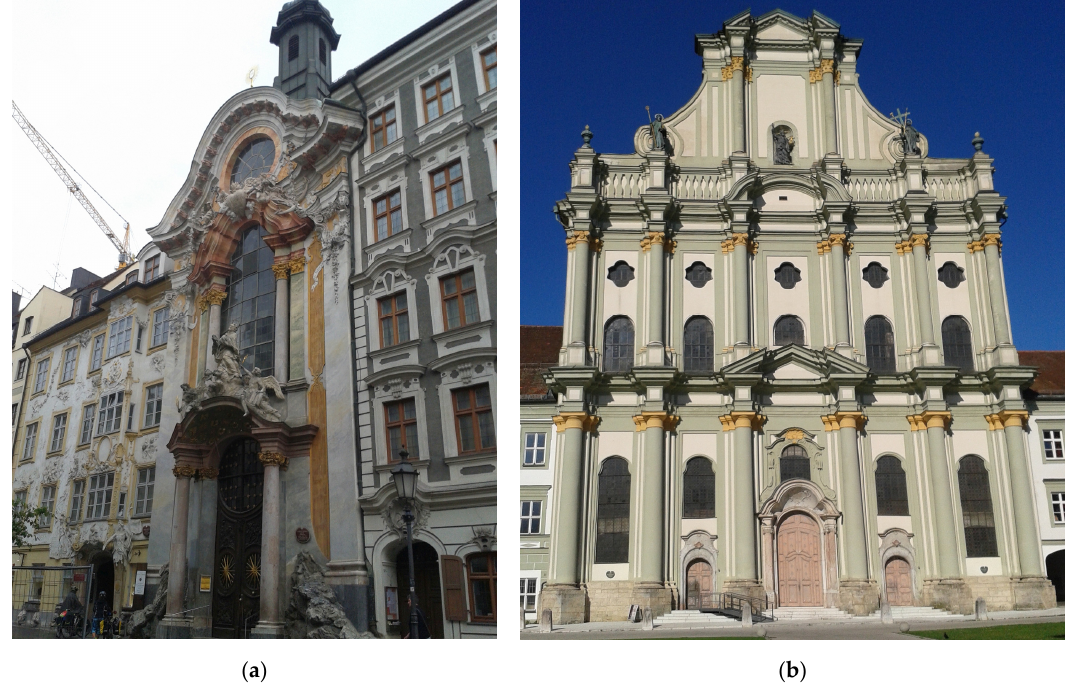
Figure 12. Two-color entablatures: ( a ) made in the marmorisation technique—the façade of the church of St. John of Nepomuceno in Munich, the so-called Asamkirche (1733–1746); ( b ) colored in shades of green—the façade of the monastery church Fürstenfeld (1701–1747). Photos by author.